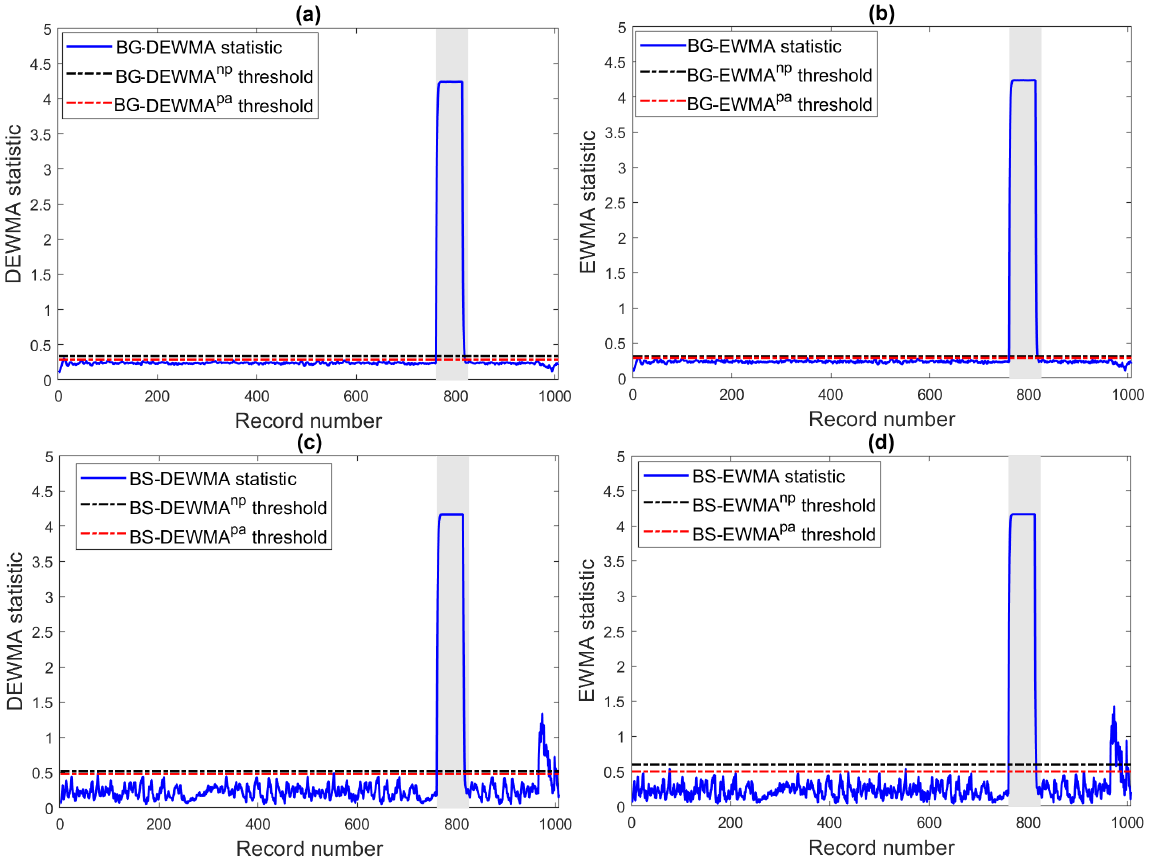
Figure 15. Results of the BG and BS-based schemes in monitoring a circuit breaker fault: ( a ) BG- DEWMA, ( b ) BG-EWMA, ( c ) BS-DEWMA, and ( d ) BS-EWMA